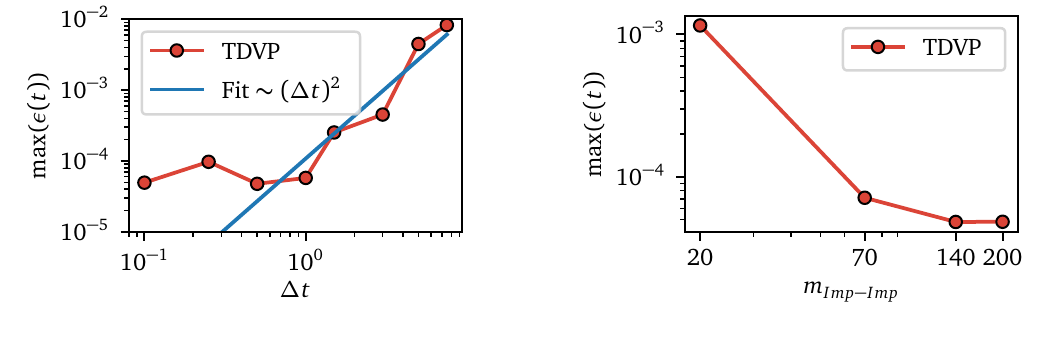
Figure 12: Error as a function of control parameters for the same AIM used in Fig. 11. We plot the maximum value of the error obtained in all four Green’s func- tions max ( ε ( t ))